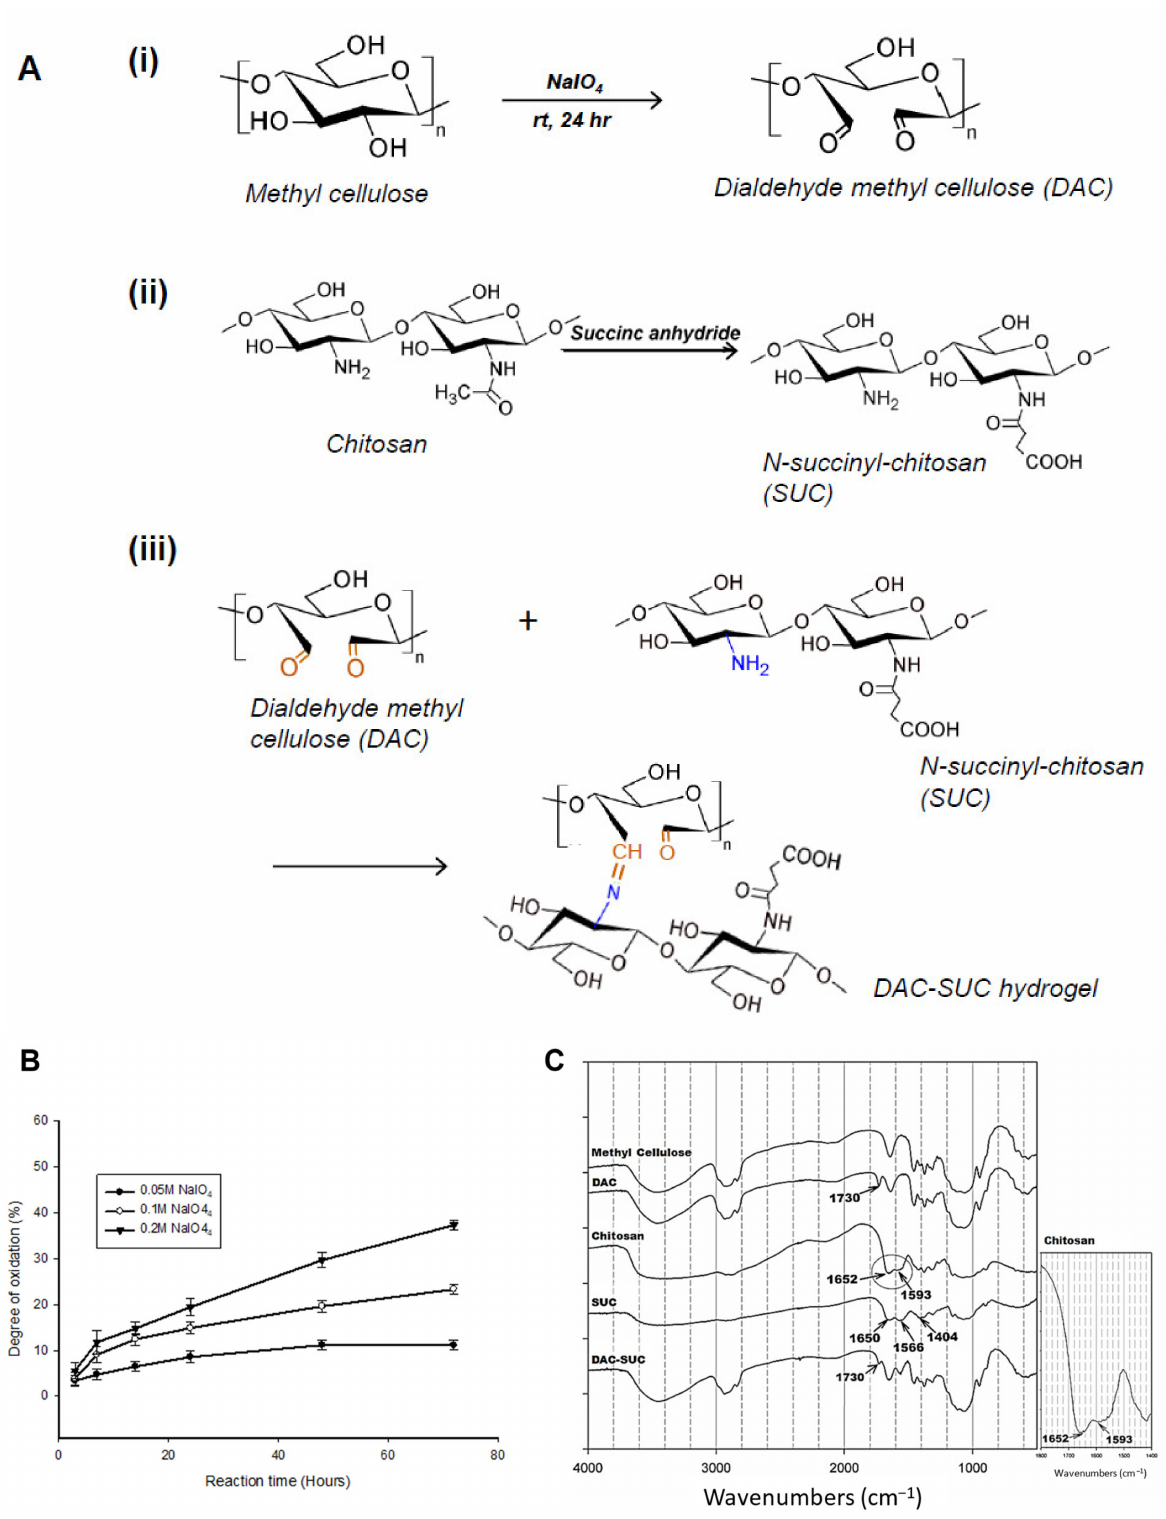
Figure 1. Characterization of DAC, SUC and the hydrogel. ( A ) Schematic representation of the synthetic route of ( i ) 2,3-dialdehydecellulose (DAC), ( ii ) succinyl-chitosan (SUC) and ( iii ) DAC-SUC hydrogel. ( B ) Oxidation percentage of DAC with different concentration of sodium periodate and reaction time. ( C ) Functional groups of methyl cellulose, DAC, chitosan, SUC, and DAC-SUC hydrogel identified by FT-IR